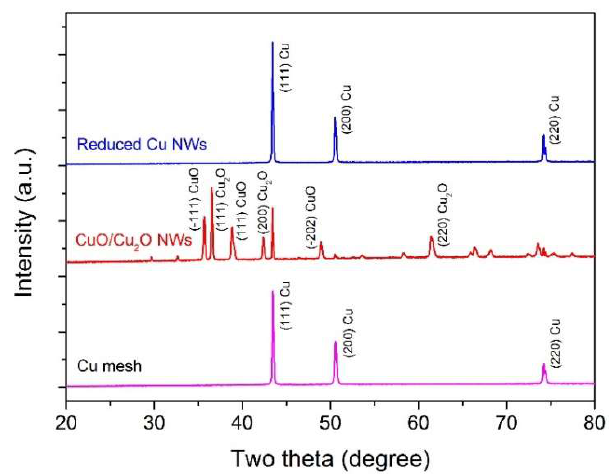
Figure 3. X-ray diffraction patterns of pristine copper mesh (magenta), annealed CuO NWs (red), and thermally reduced Cu NWs (blue).